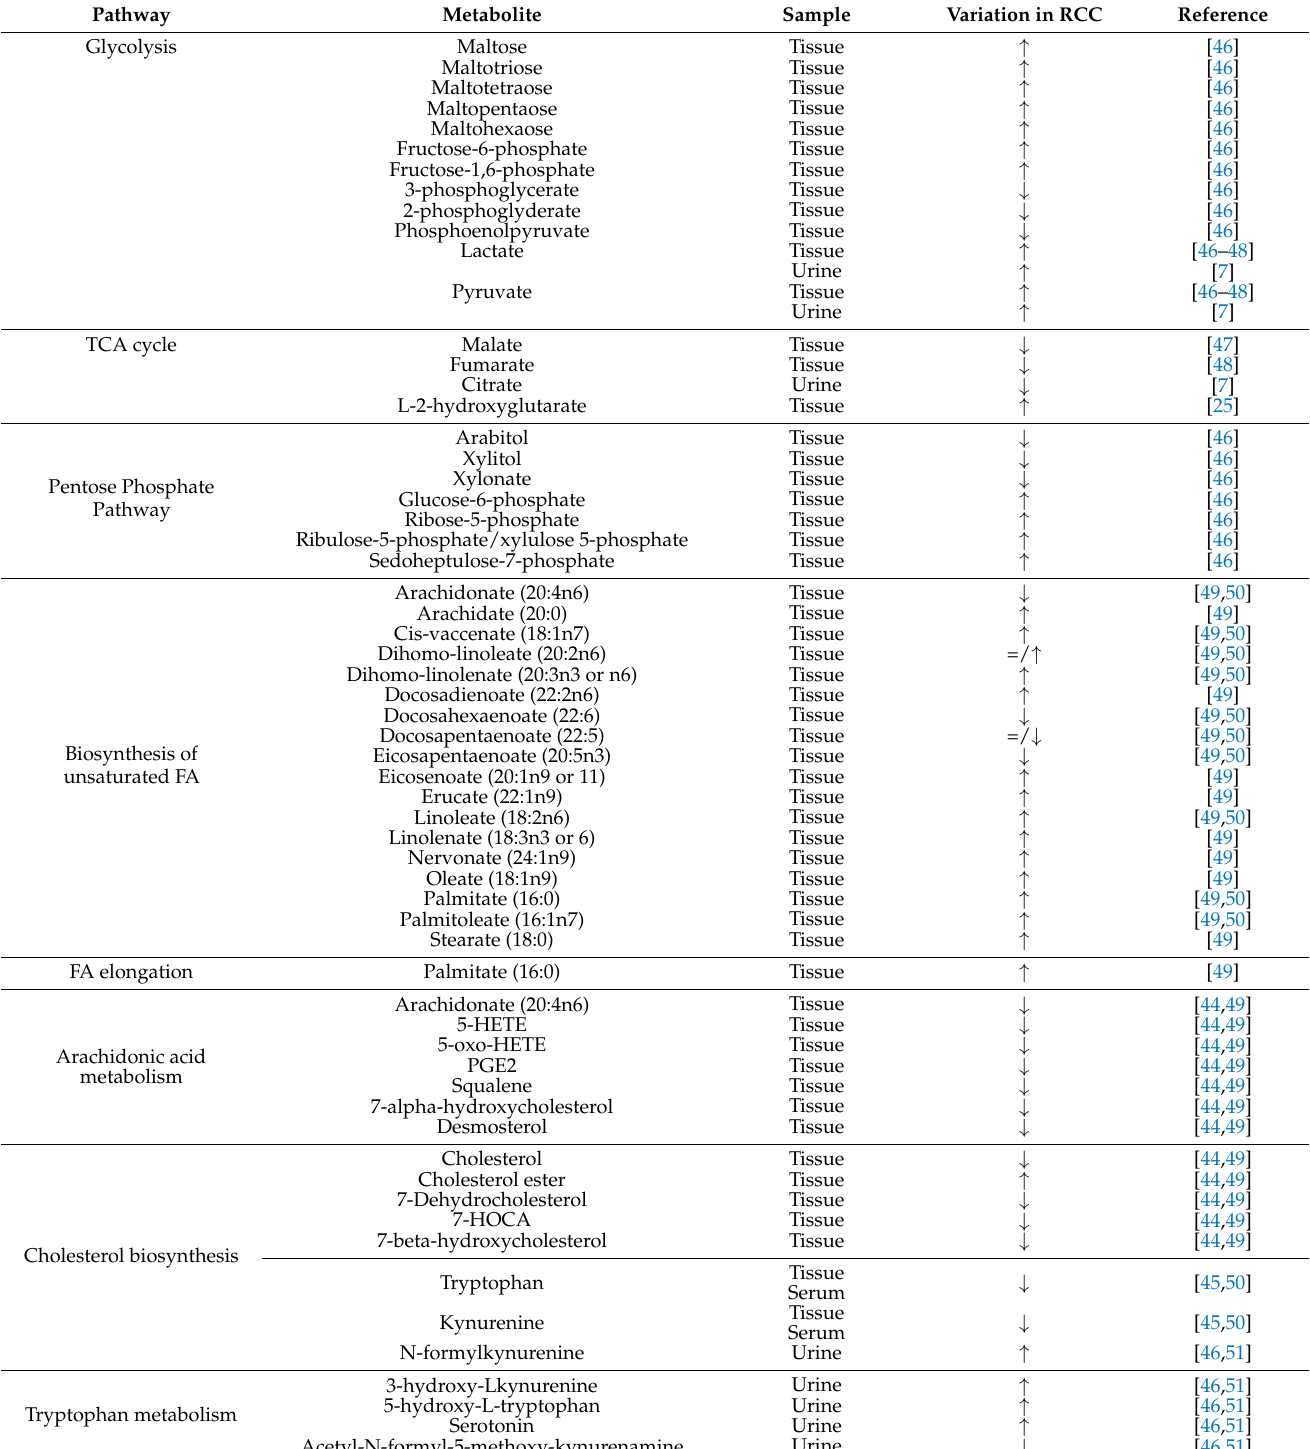
Arrow indicates accumulation ( ↑ ) or deprivation ( ↓ ). (=) indicates no